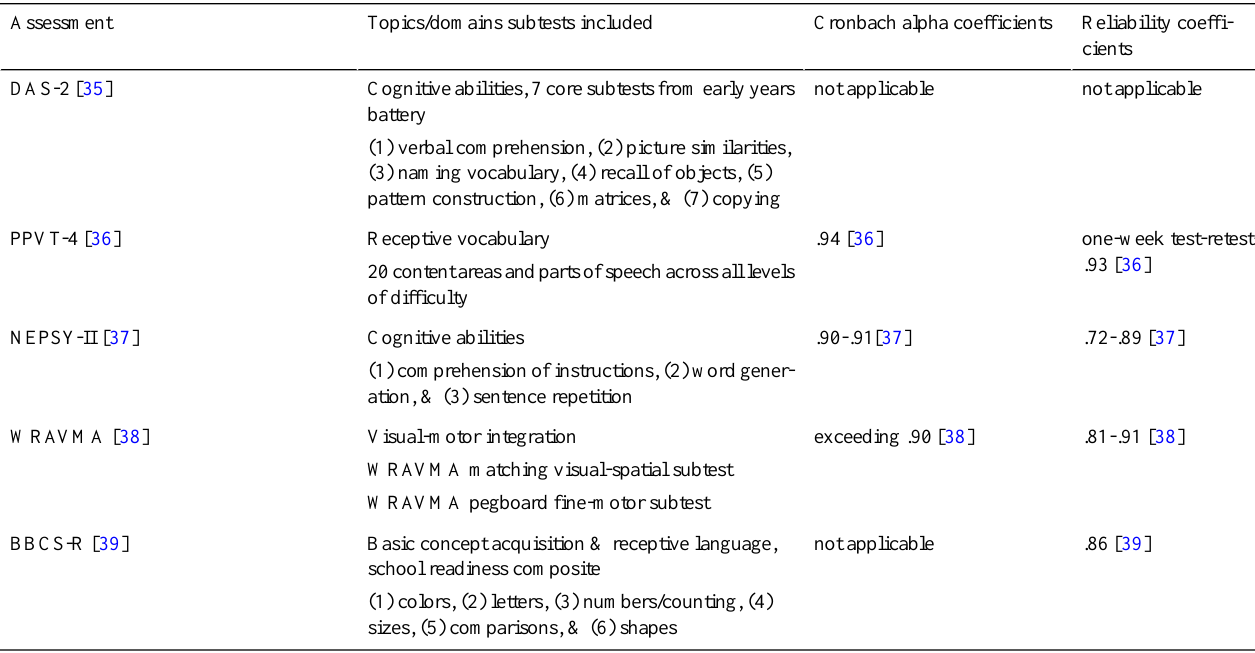
Table 2. The child assessments to be administered (in-person component